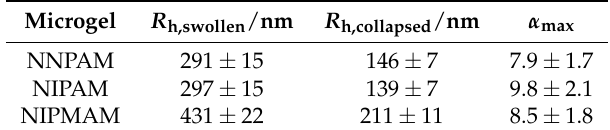
Table 3. Summary of the hydrodynamic radii of the homopolymer microgels in the swollen and collapsed state in combination with the maximum swelling ratio α max . The error of the radii corresponds to an estimated deviation of 5%. This value includes not only the inaccuracy of the measurement but also the very low polydispersity of the sample.